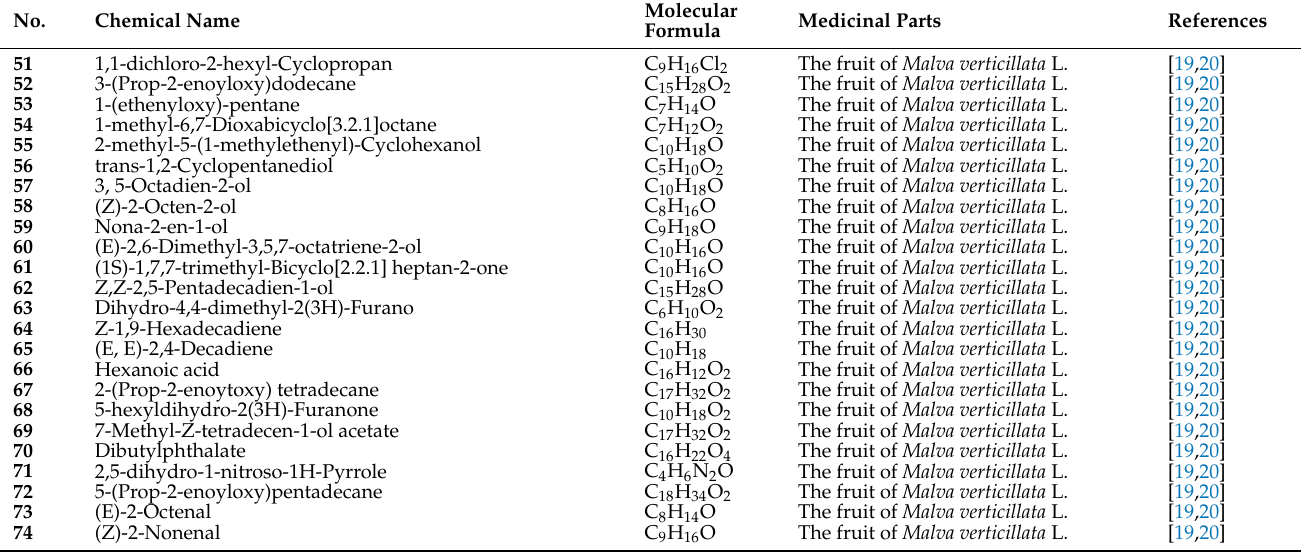
Table 5. The volatile oils identified from Fructus Malvae .